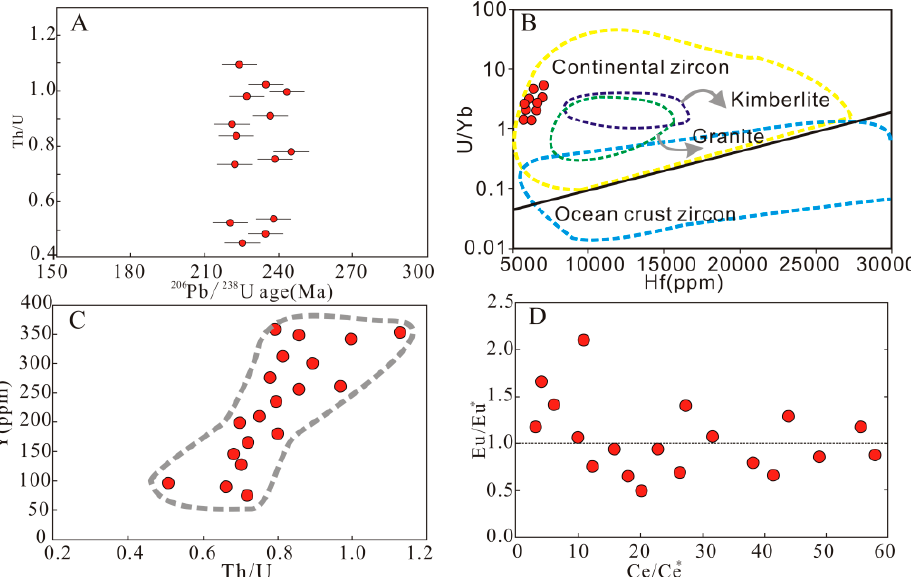
Figure 8. Plots of Th/U vs. U–Pb age ( A ), Hf concentration (in ppm) vs. U/Yb ( B ), Y concentration (in ppm) vs. Th/U (The initial data source: [32]) ( C ) and the relation between the measured Eu and Ce anomalies ( D ).